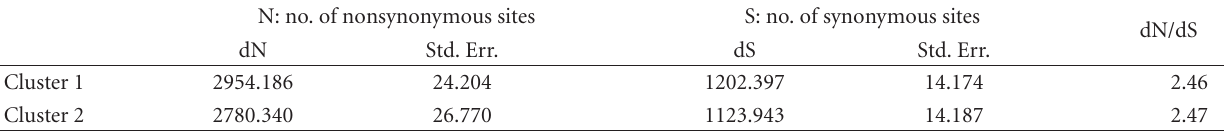
Table 2: Test for selection by modified Nei and